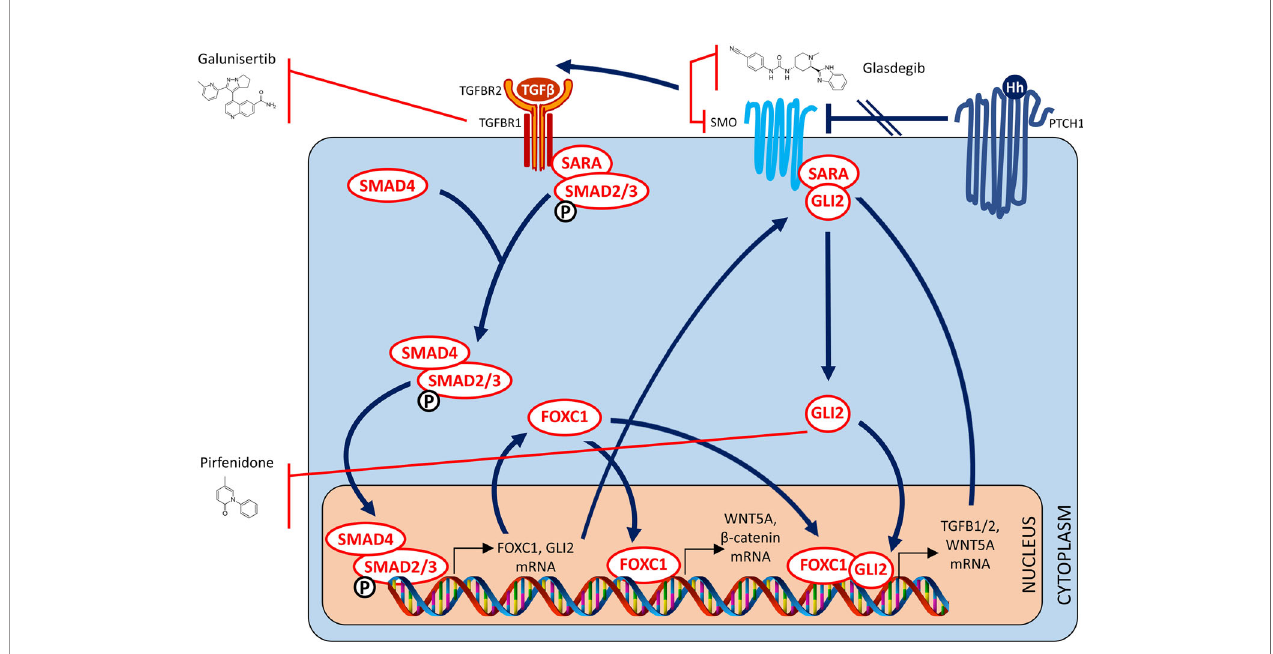
FIGURE 4 | Targeted TGF- b and hedgehog therapy strategies for FOXC1-overexpressing pro-metastatic cancers – II. Drugs that target the TGF Beta and Hedgehog signaling